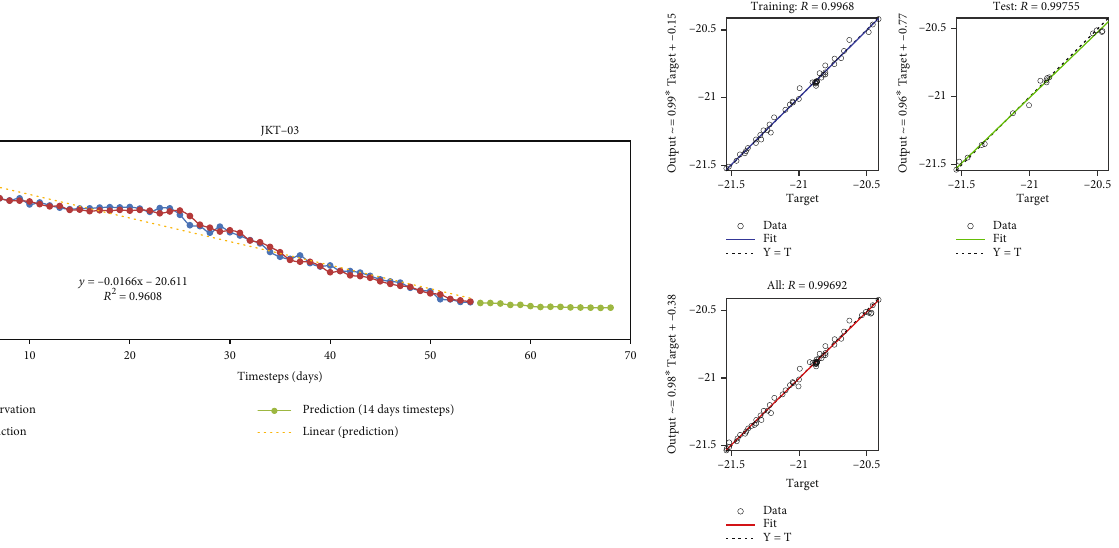
Figure 7: NARX prediction and model performance for JKT-03.